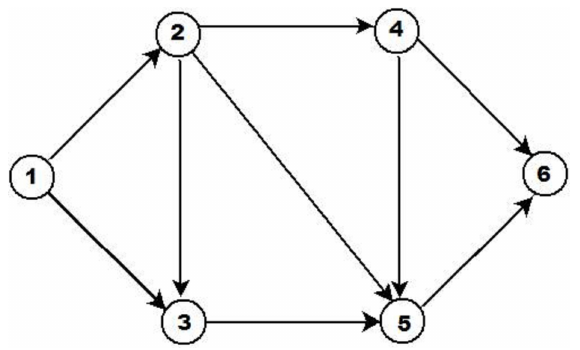
Figure 3. A classical graph with six nodes and nine